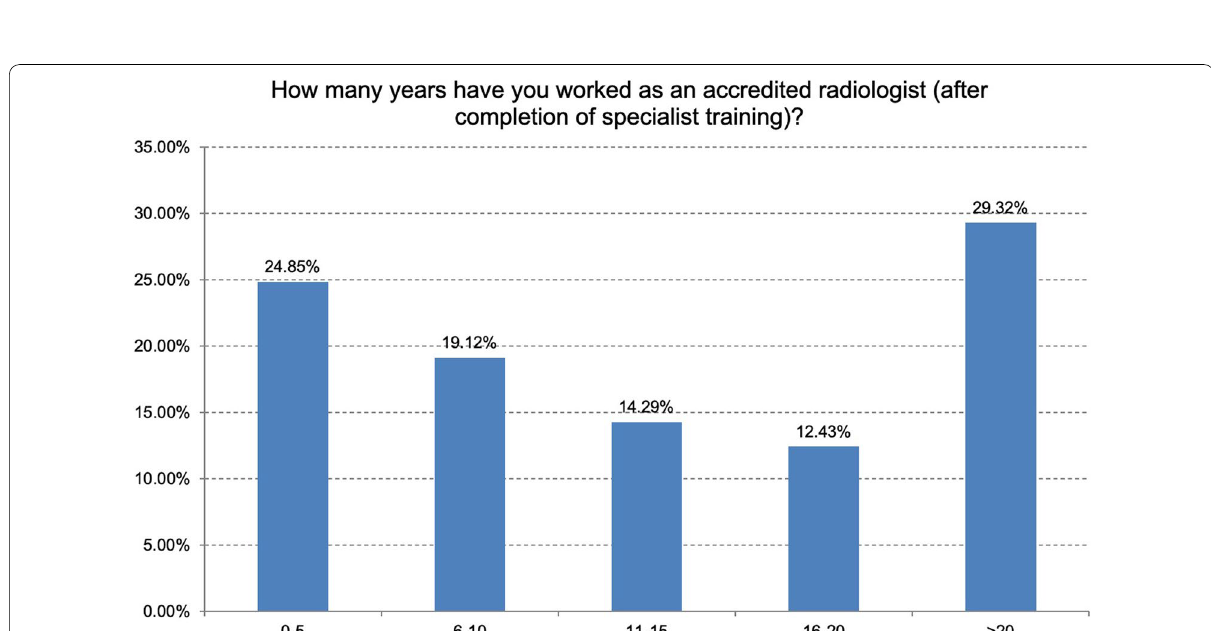
Fig. 2 The time working as a fully accredited radiologist (responses n